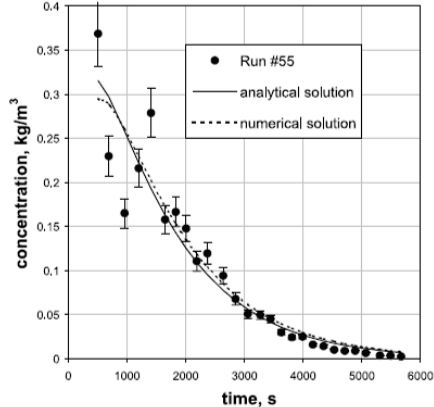
Figure 15. Comparison of the experimental data to the model results (both analytical and numerical solutions). Adopted with permission from [38].